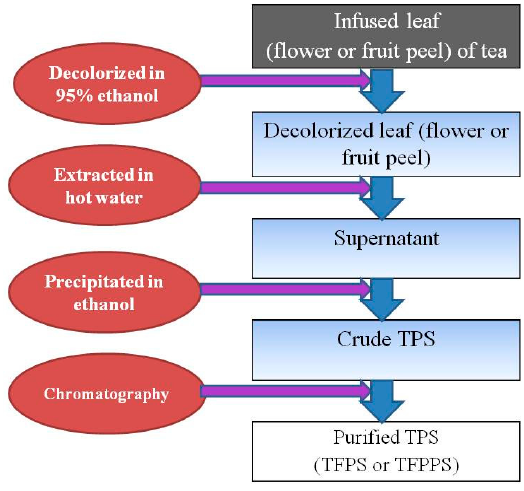
Figure 1. Procedure for preparing TPS.